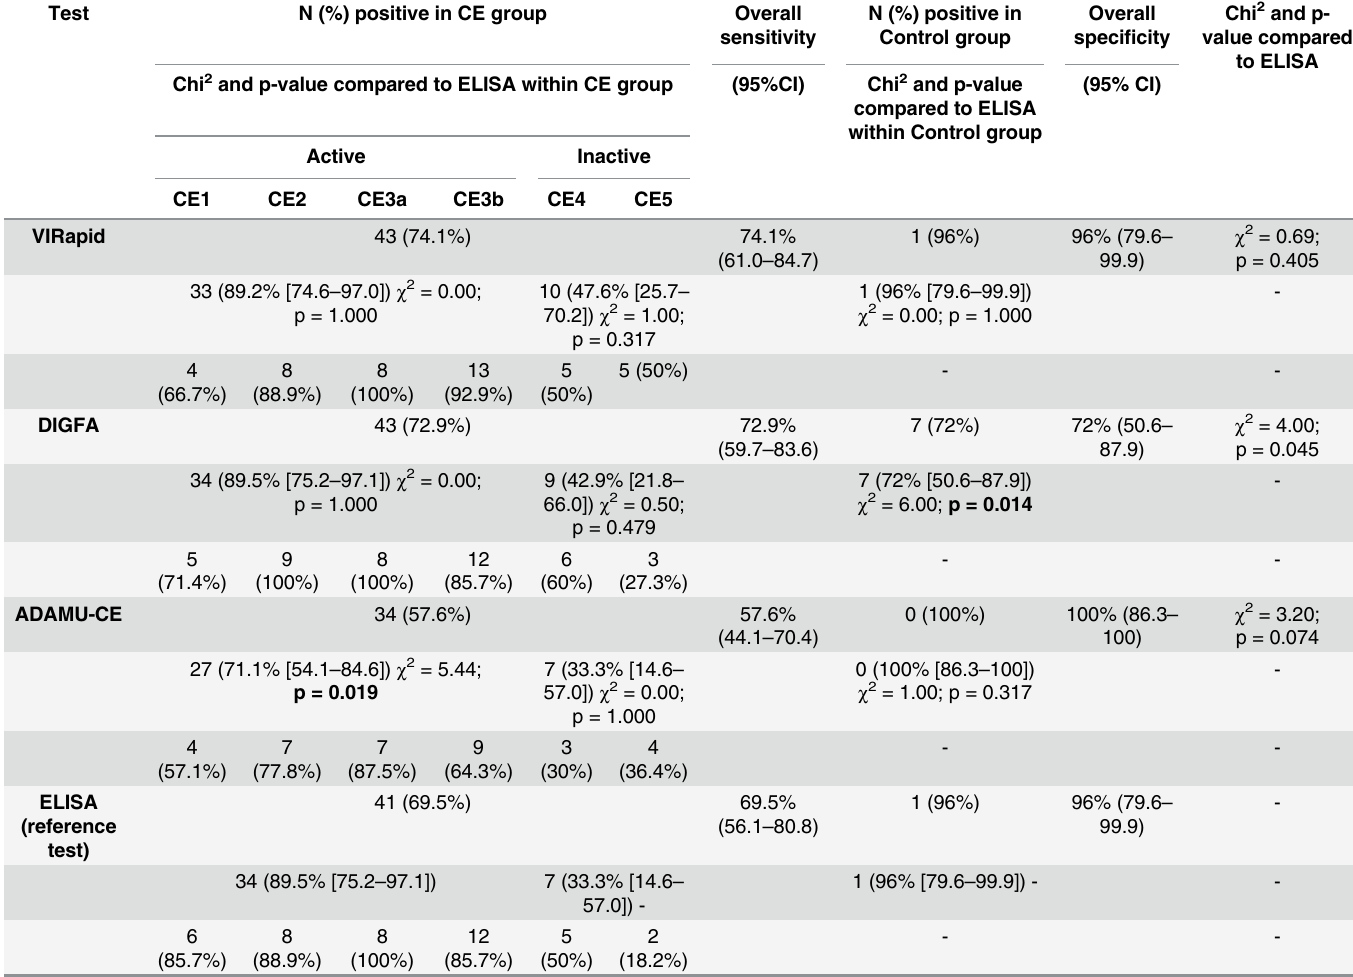
Table 2. Tests sensitivity and specificity. Results are compared with those of the ELISA test. US diagnosis was used as the gold standard. Significant dif- ferences are indicated in